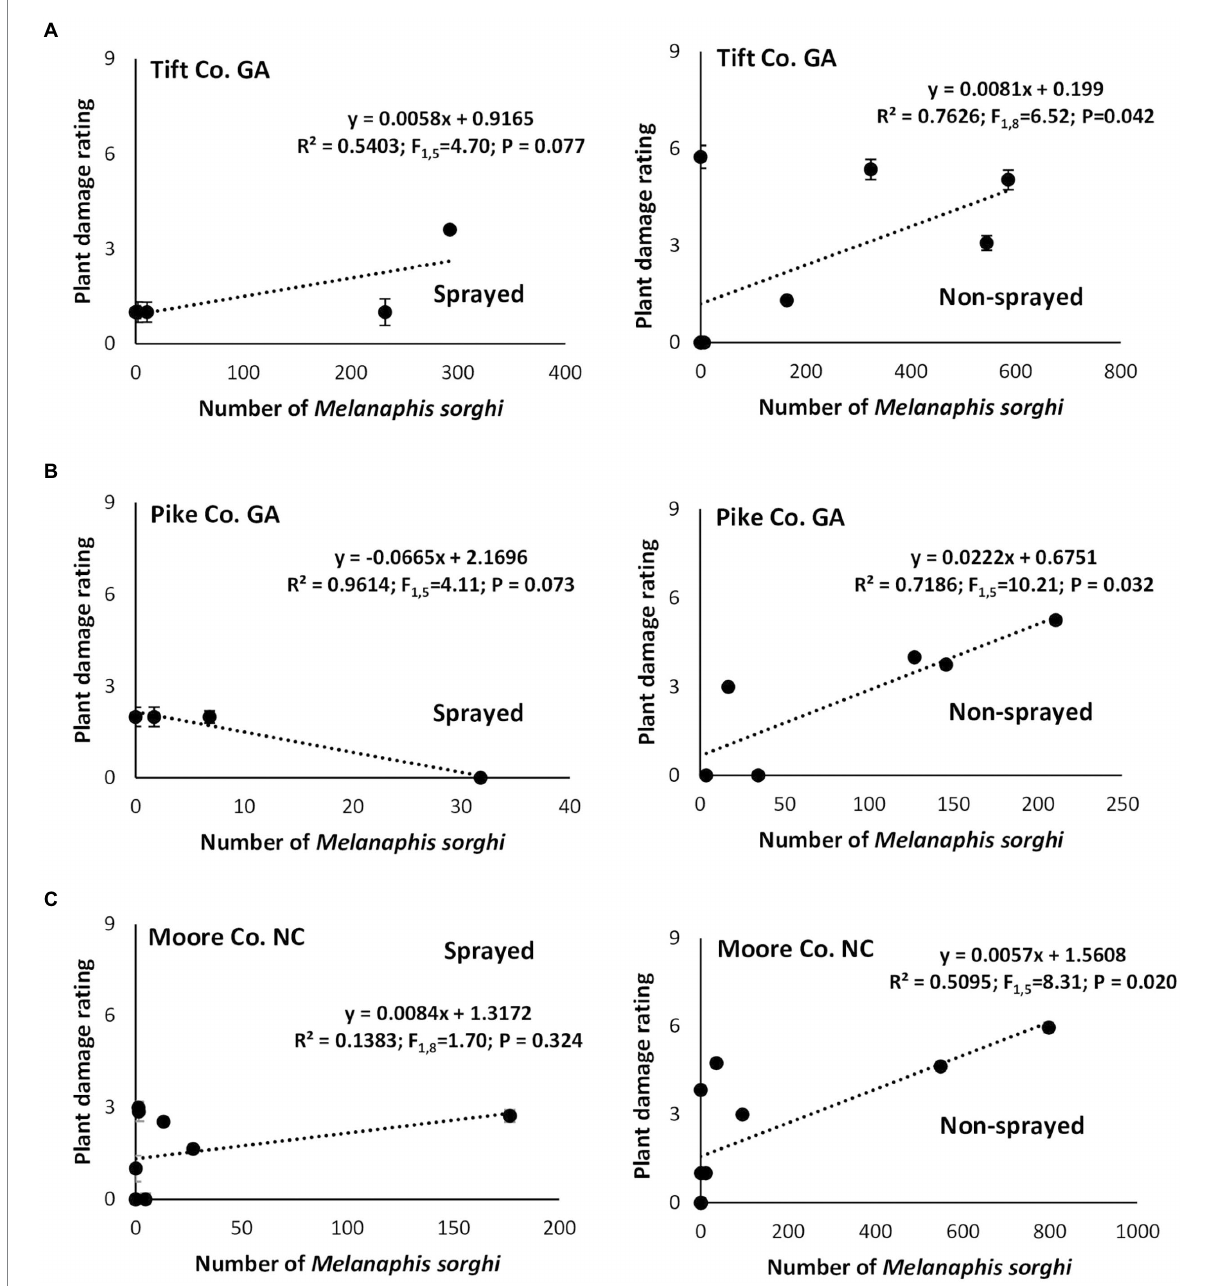
FIGURE 3 Relationship between mean weekly Melanaphis sorghi counts and corresponding plant damage rating in flupyradifurone sprayed and non-sprayed susceptible sorghum cultivar (DKS53-53) at Tift Co. (A) , Pike Co. GA (B) , and Moore Co. NC (C) in 2018.